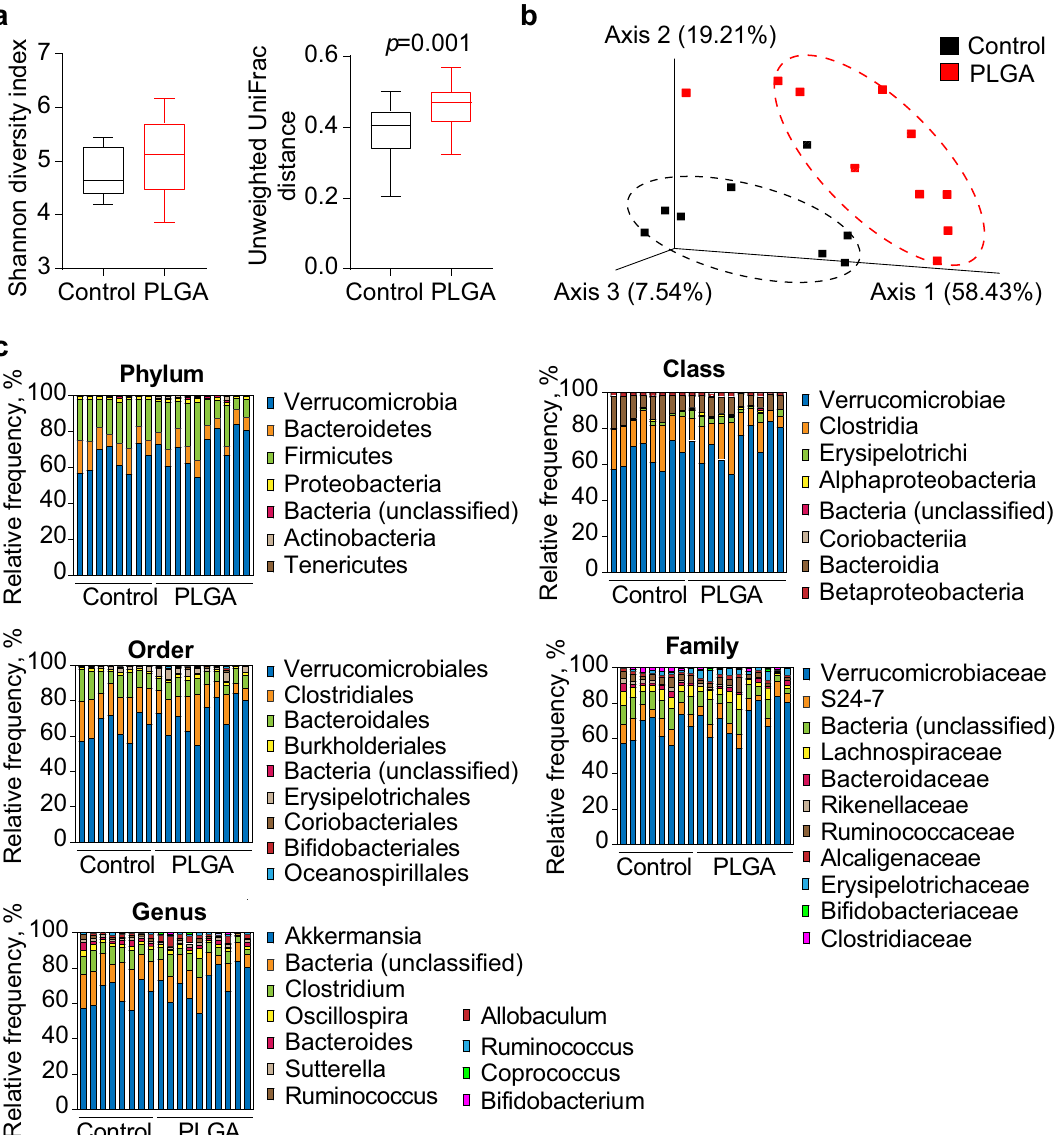
Figure 3. Bacterial diversity measurements show that gut microbiota diversity was affected by treatment. ( a ) Alpha diversity was determined using the Shannon diversity index on raw OTU abundance after filtering out contaminants (not significant, p = 0.286). However, when comparing phylogenetic tree information between groups using the unweighted unique fraction (UniFrac) distance measurement, there was a significant difference regarding gut microbiota diversity (pairwise Permanova) (n = 10/group); ( b ) Gut microbiota composition similarity among groups was represented using a principal coordinate ordination, based on weighted UniFrac distances, where points are individual samples; ( c ) Stacked column graphs show the relative frequency of bacterial species in control and PLGA mice in the gut microbiota of cecum feces, analyzed using Qiime2 Naive Bayes classifier using Greengenes (v13.5). Statistics: n = 10 mice/group, pairwise Kruskal–Wallis test (when comparing diversity indices), p <